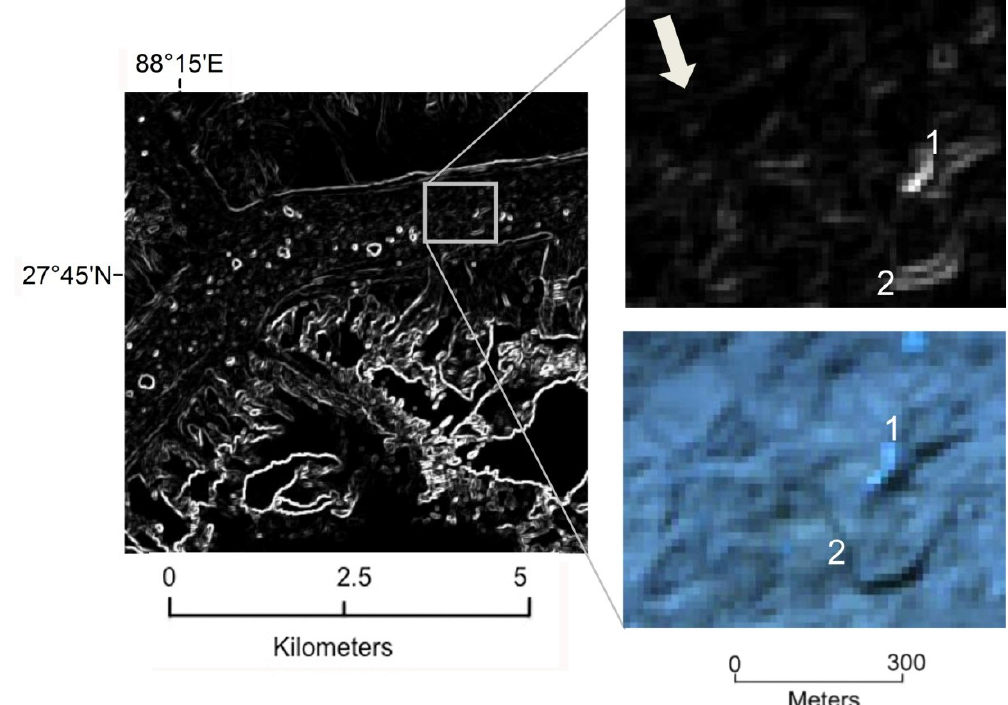
Figure 13. ( left ) Variance measure derived from PC1 using a 3 × 3 moving window zoom, shown for the middle section of. The distinct pattern of supraglacial lakes is visible as circular features. Labels on the zoomed figures point to: 1-a supraglacial lake on the north side of the ice wall; 2-moon-shaped ice walls shown on the variance image ( upper right ) and original ASTER 321 color composite ( lower right ). The arrow points in the direction of the sunlight at the time of acquisition of the image (sun azimuth = 162 degrees).